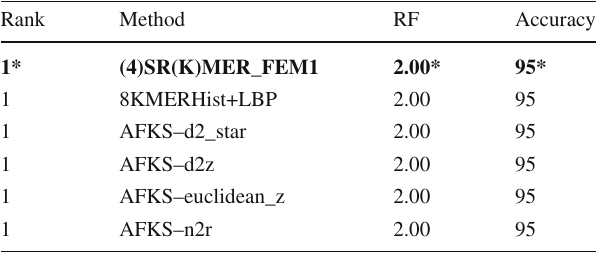
indicates top results